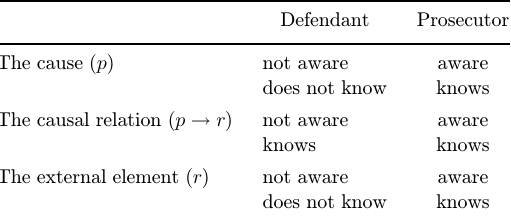
Table 2. Comparison of epistemic statuses between defen- dant and prosecutor.